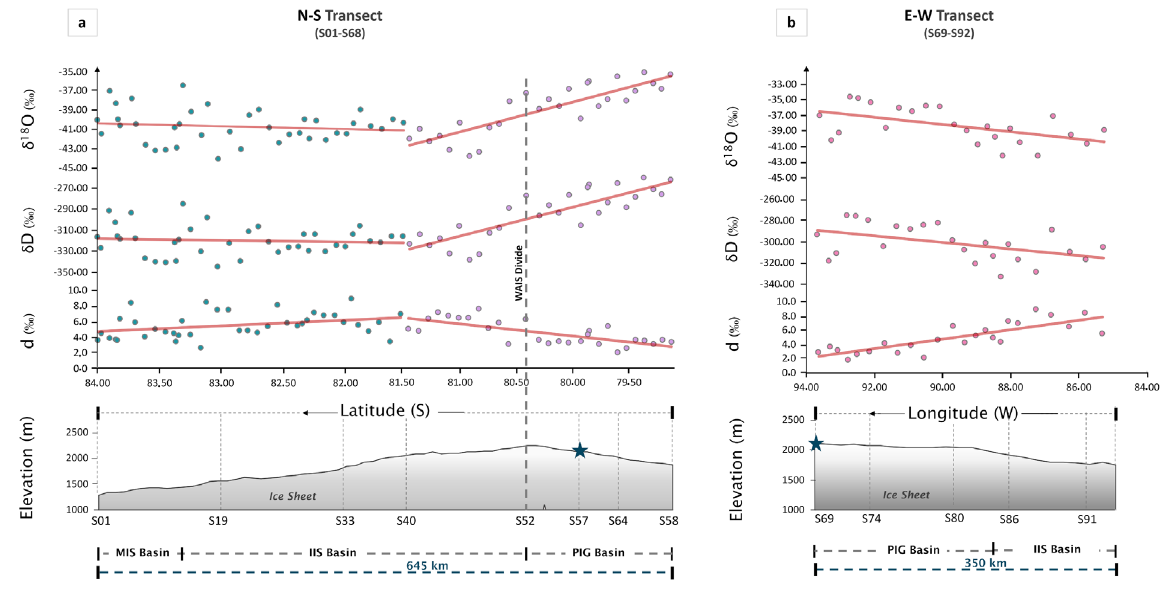
Figure 2. Water stable isotope ratios (δ 18 O, δD, and d -excess) spatial variation along the N-S (a) and the E-W (b) transects. Blue stars indicate the intersection of the N-S with the E-W